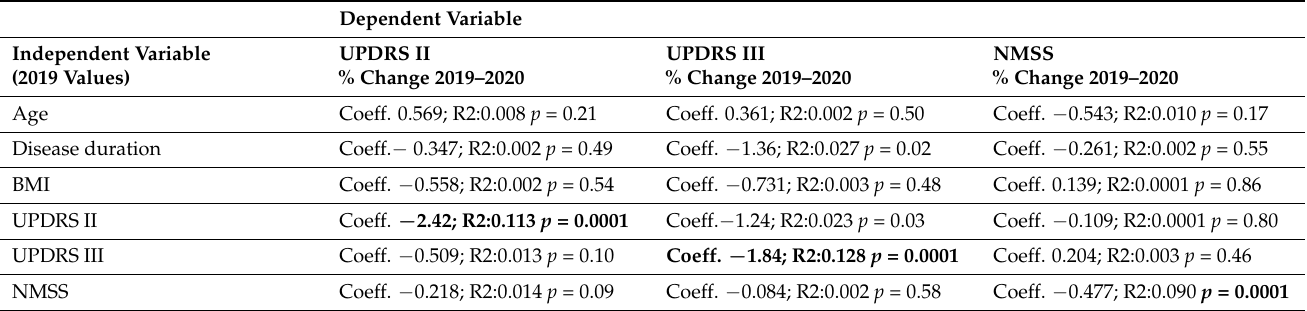
Table 2. Results of the simple regression analysis matching different independent variables with %changes observed in 2019–2020 in the primary outcome measures. Statistically significant correla- tions are in